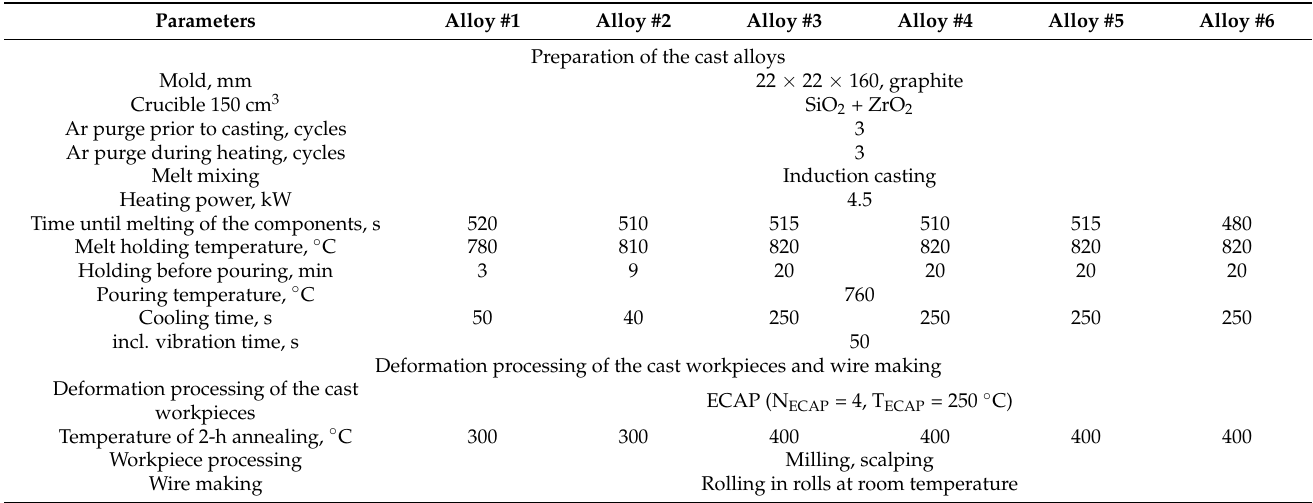
Table 2. The preparation regimes of the